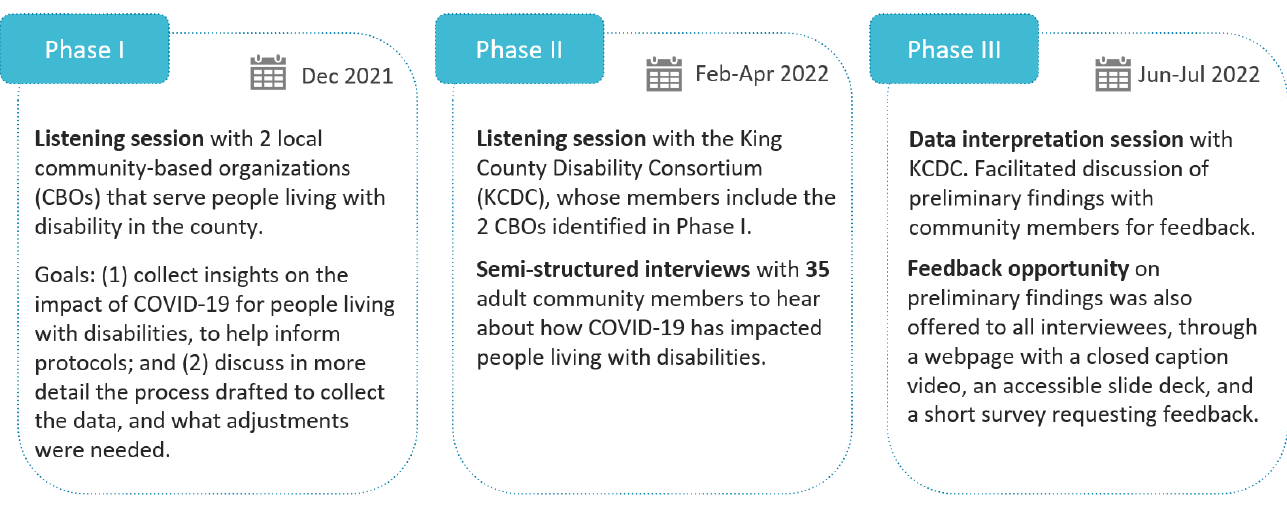
Figure 1. Data collection phases.